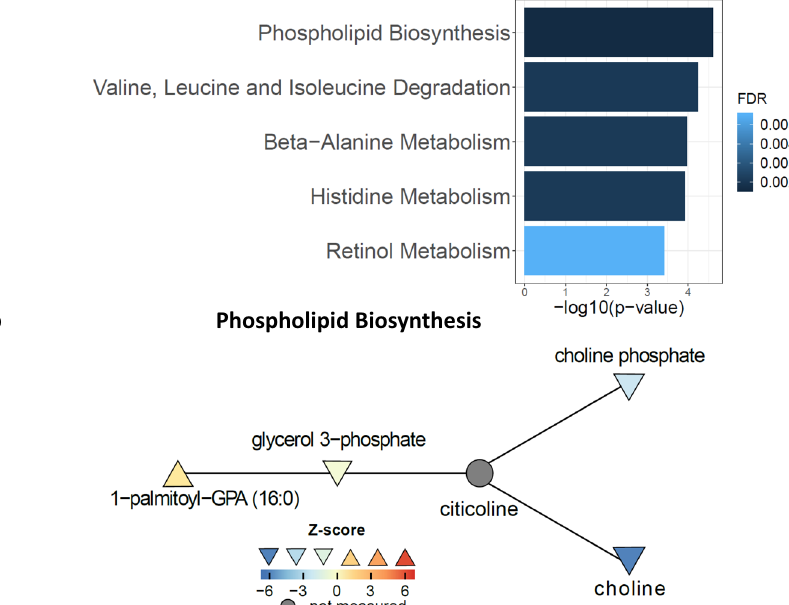
Fig. 3 Phospholipid biosynthesis and other top-ranking differential pathways. a Top-ranking differential pathways. Graph illustrates – log 10 ( p -values) and false discovery rates (FDRs), with bars colored by FDR, from Limma Roast ’ s Mixed statistic 87 (which is one-sided) adjusted with FDRs. b Phospholipid biosynthesis network. Nodes are colored by between-group z-score, whereas unmeasured nodes are colored dark gray. Orientation of triangle also indicates the directionality of regulation. Connections are from the Pathway Commons network. Source data are provided as a Source Data fi